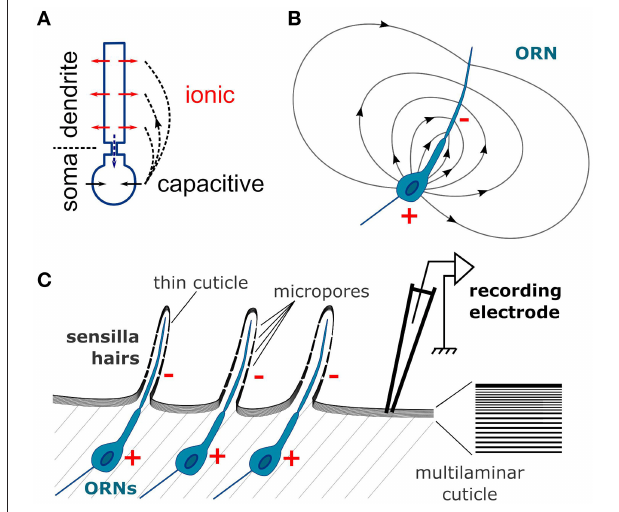
FIGURE 10 | Schematic depiction of the CSD theory applied to the insect antenna. (A) Conventional CSD model. Each neuron is depicted as two compartments, dendrite and soma. The neuron is activated via an ionic current (red arrows) in the dendrites that induces a current sink in the extracellular medium. At the same time a capacitive current in the soma (black arrows) induces a current source in the extracellular medium. The current flowing intracellularly between the compartments (dashed blue arrow) is equal and opposite to the current flowing in the extracellular medium (dashed black arrows). (B) Electric field generated by an ORN in a homogenously conductive medium. Since the ORN is asymmetric, it results in an electric dipole in the extracellular medium. The single dendrite is the negative pole ( − ) and the soma is the positive pole ( + ). (C) The organization of the neuronal tissue in the antenna is ideal for generating field potentials. Individual ORNs are perfectly aligned below the cuticle surface. The components of the electric fields perpendicular to the plane of alinement sum up for generating the EAG signal. Right: zoom on the cuticle microstructure. Since the cuticle has a multilaminar organization, it should have an anisotropic conductivity and the electric current should flow in the tangential